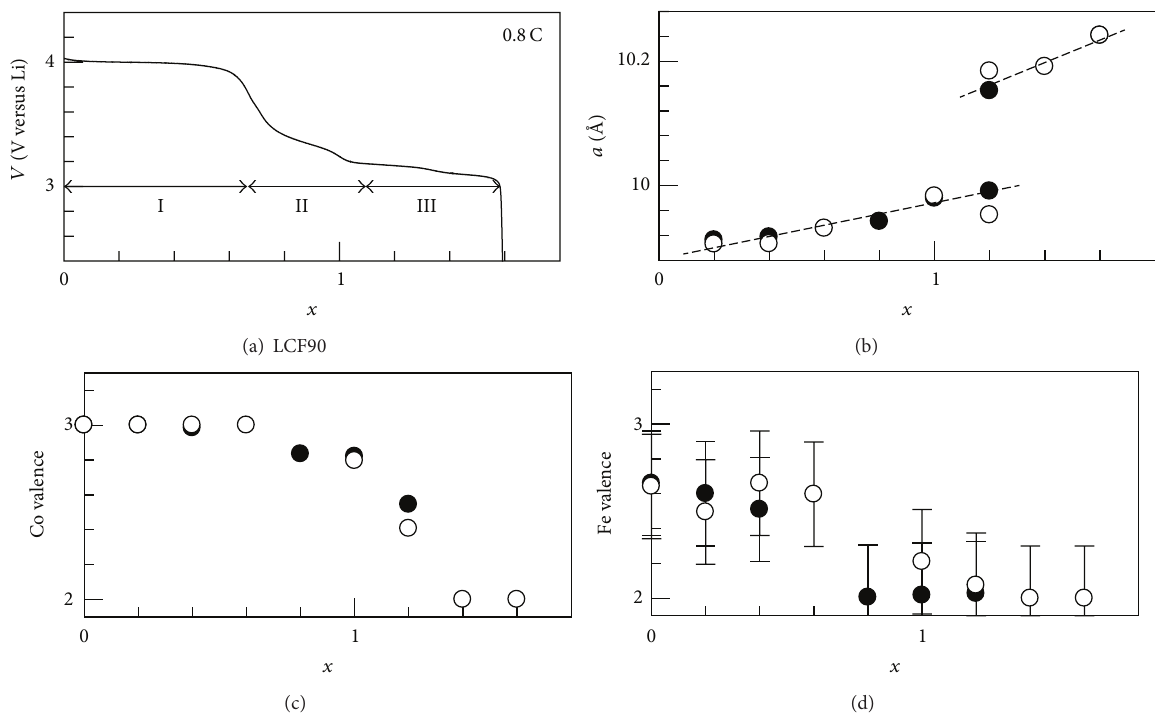
Figure 12: (a) Discharge curve, (b) lattice constant (a), (c) Co valence, and (d) Fe valence of NCF90 against 𝑥 . Open (filled) marks in (b), (c), and (d) mean that the data are obtained in the charge (discharge) run (cited from [20]).